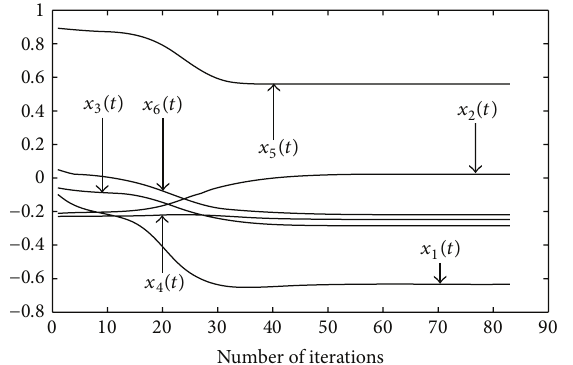
Figure 11: Trajectories of 𝑥(𝑡) , the solution of (40), with initial 𝑥(0) as (55), which should converge to an eigenvector of 𝐴 corresponding to the eigenvalue 𝜆 2 .